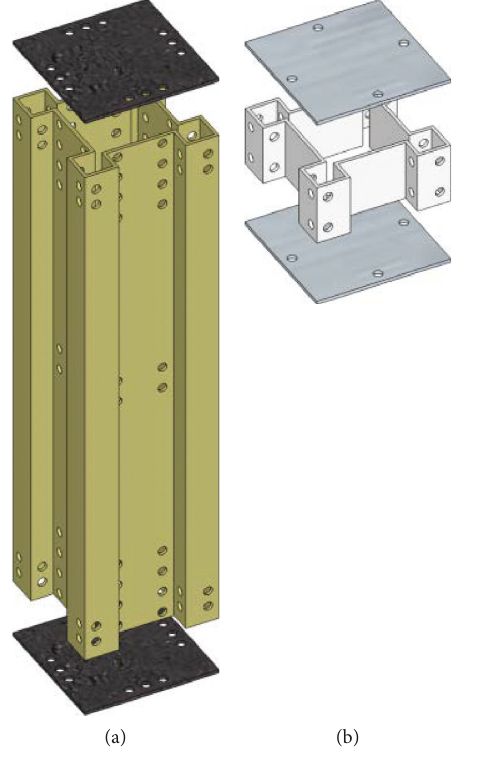
Figure 6: Forming the basic units: profile and closing